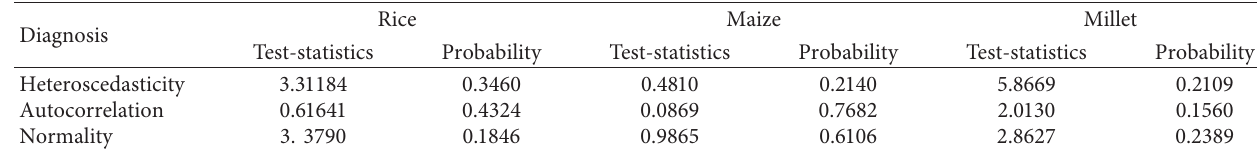
Table 3: Diagnostic test statistics for food crop production.